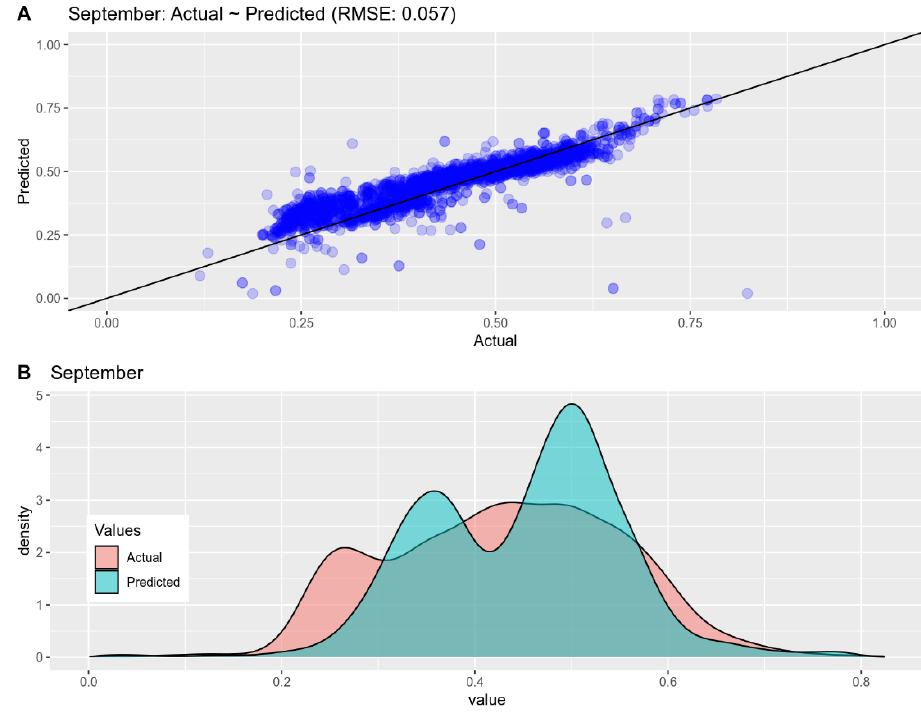
Figure A9. Comparison between actual~predicted for September 2020.